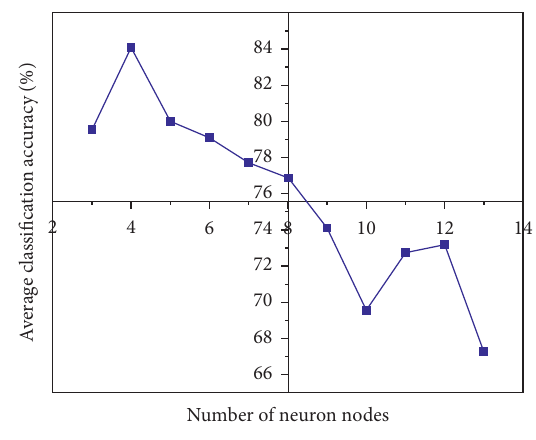
Figure 6: Relationship between average classification accuracy and neuron node number.